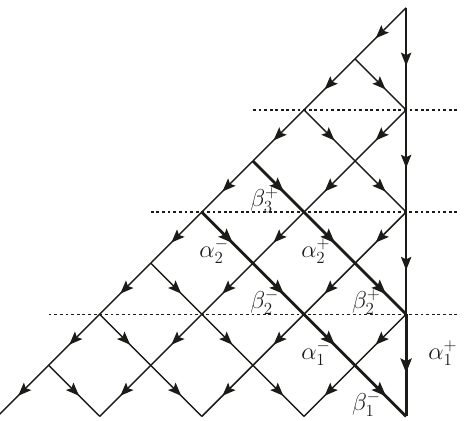
Figure 4 . Diagrammatic representation for an eigenfunction of the operator b B N for an inhomoge- neous open spin chain for N = 5. The modi(cid:12)ed propagators are shown by fat lines with arrows. The corresponding modi(cid:12)ed indices are (cid:11) (cid:6) spin in the integration measure in the vertices is always given by the half sum of the indices of the outgoing lines. The dashed lines separate di(cid:11)erent